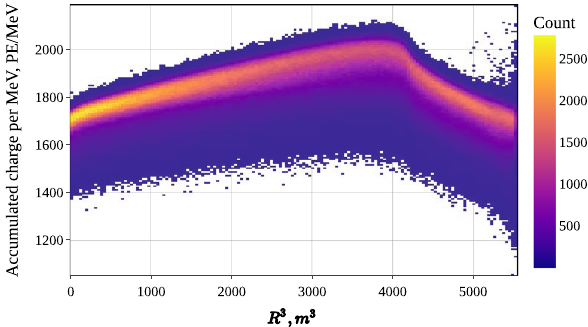
Fig. 3 Accumulated charge on PMTs per 1 MeV of deposited energy as a function of the radius cubed R 3 for